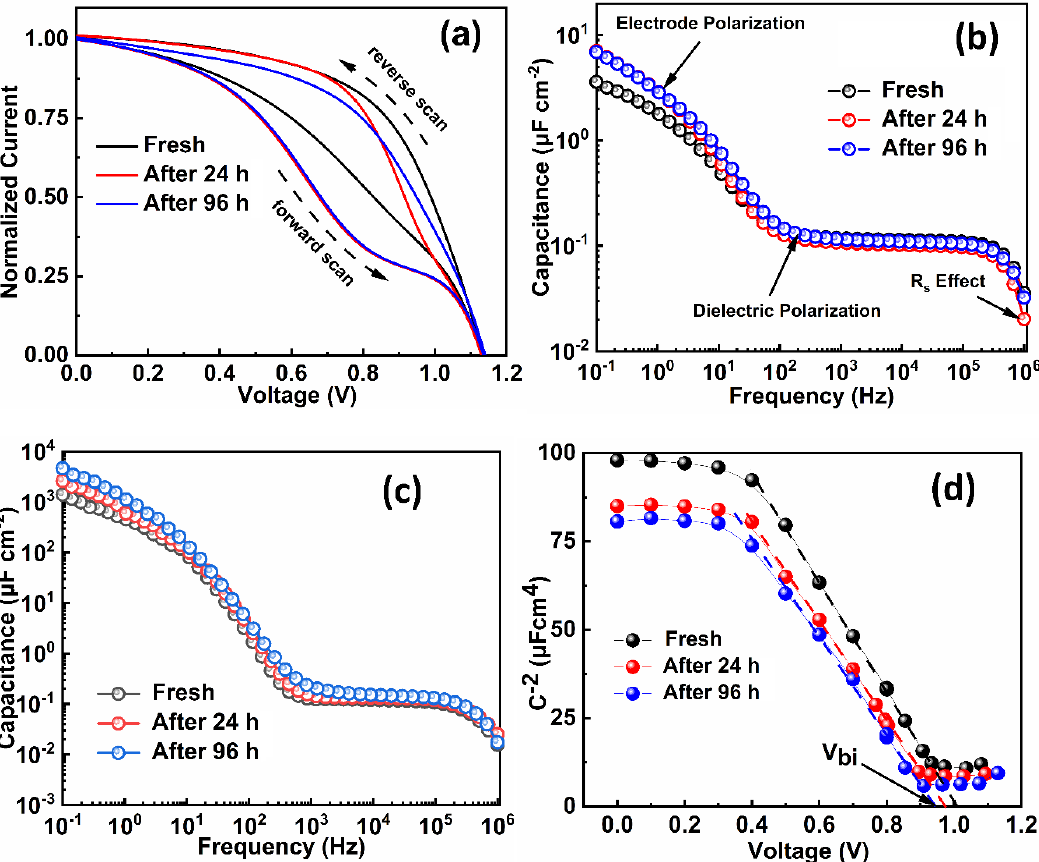
Figure 3. ( a ) Normalized J − V hysteresis characteristics of the device under AM 1.5 G light illumination as a function of time. Capacitance–frequency response of the device in a frequency range of 100 mHz to 1 MHz with time under ( b ) dark and ( c ) light. ( d ) Mott–Schottky plots of the investigated devices at 1 kHz.